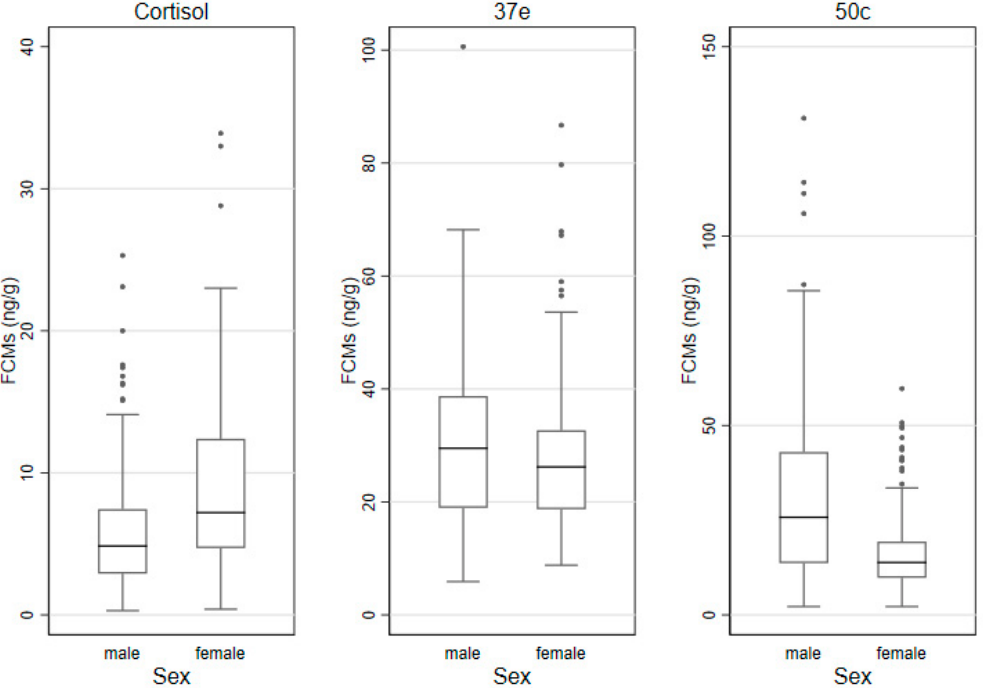
Figure 2. Box and whisker plots for FCM (faecal cortisol metabolite) levels (ng/g) measured with the cortisol, 37e (5 α - pregnane-3 β ,11 β ,21-triol-20-one) and 50c (tetrahydrocorticosterone) EIAs (enzyme immunoassays), as grouped by sex (defecations: males n = 164; females n = 187).